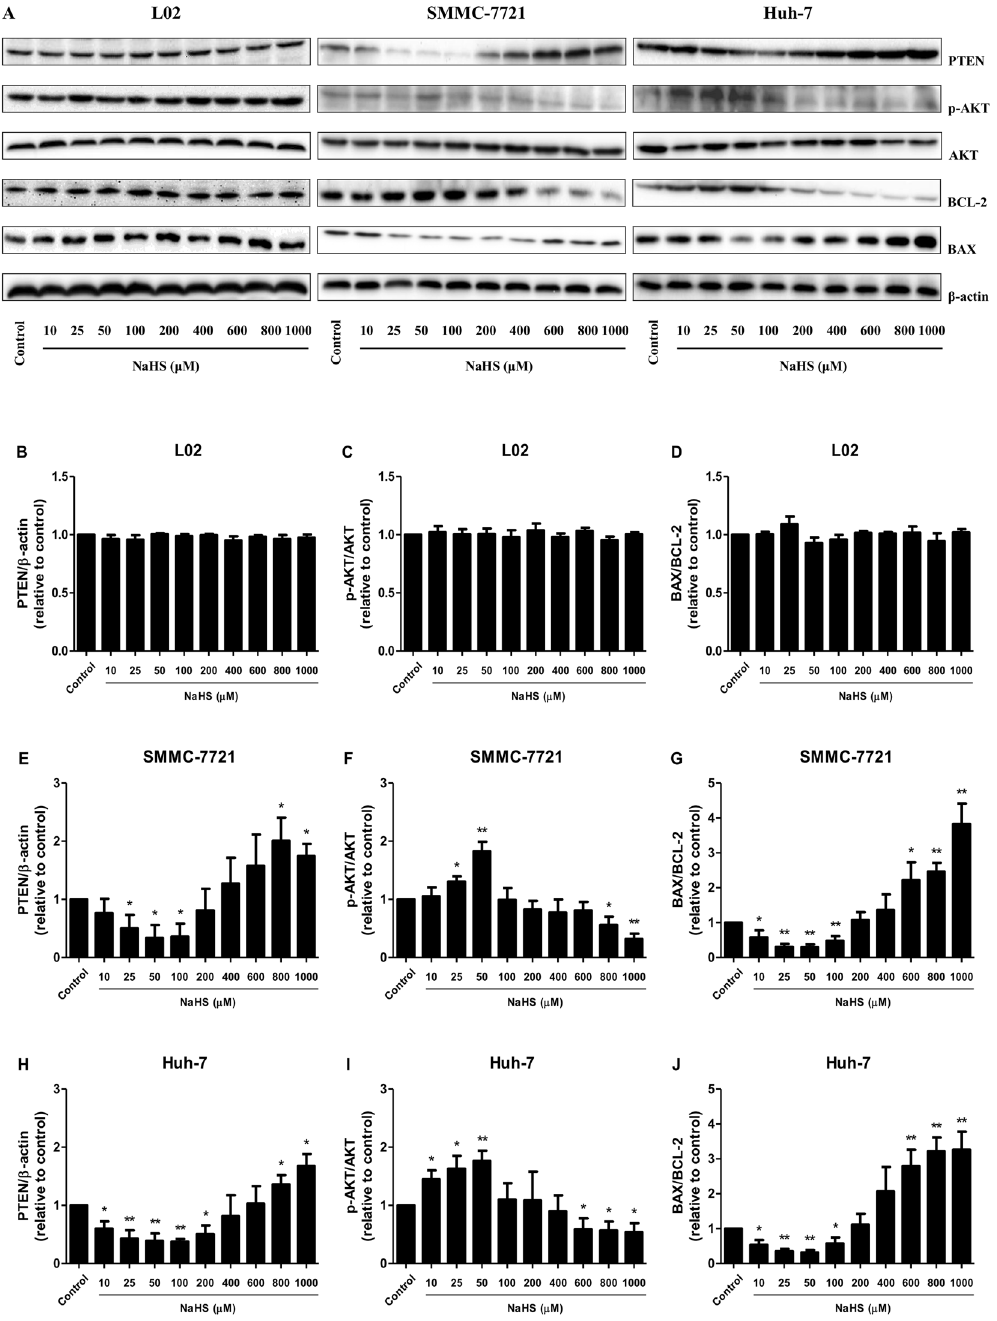
Figure 6. H 2 S mediated the PTEN/AKT pathway in human HCC cells. L02, SMMC-7721, and Huh-7 cells were cultured in 6-well plates and treated with NaHS at concentrations of 0 (Control), 10, 25, 50, 100, 200, 400, 600, 800, and 1000 μ M for 24 h, then the protein expression levels of the indicated factors were examined by Western blot. β -actin was used as the loading control. The densitometry analysis of each factor was performed, normalized to the corresponding β -actin level. Values were presented as mean ± SEM of three independent experiments; * P < 0.05, ** P < 0.01 compared with the control